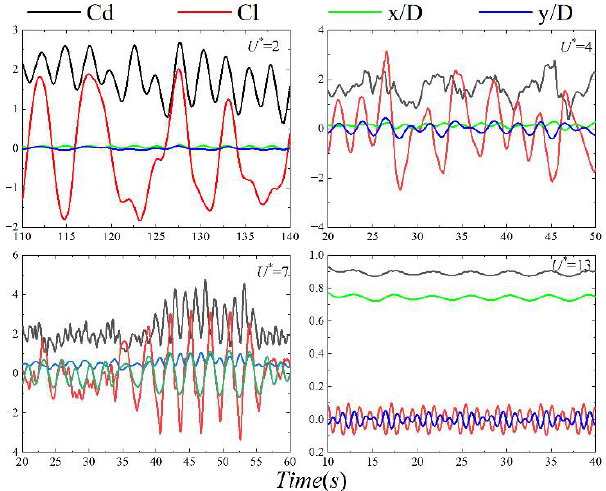
Figure 17. Time history of the force coefficients and displacement for CR 33.